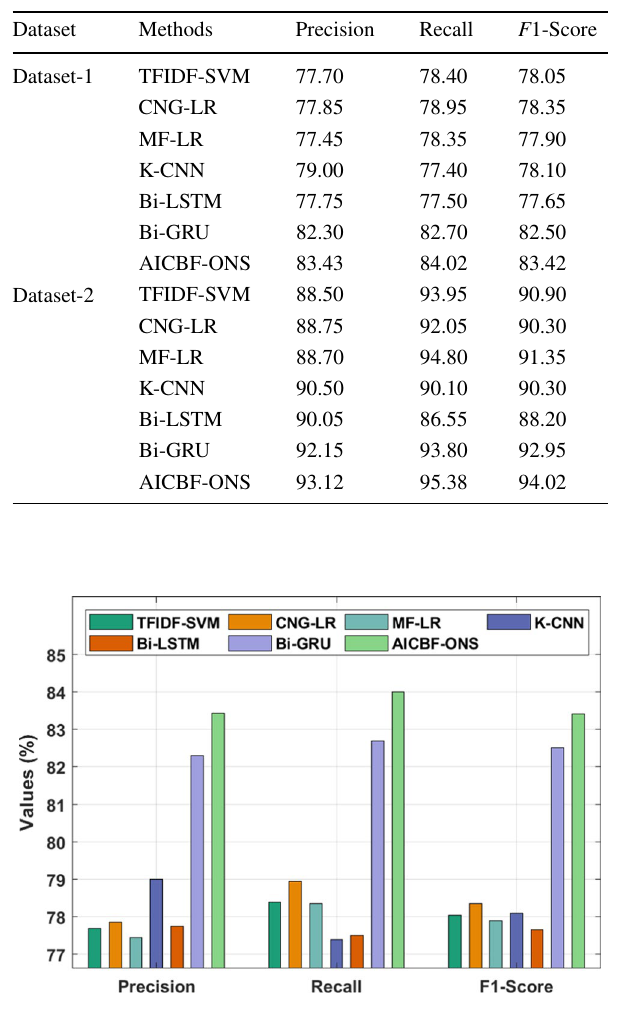
Fig. 7 Comparative analysis of AICBF-ONS model on Dataset-1